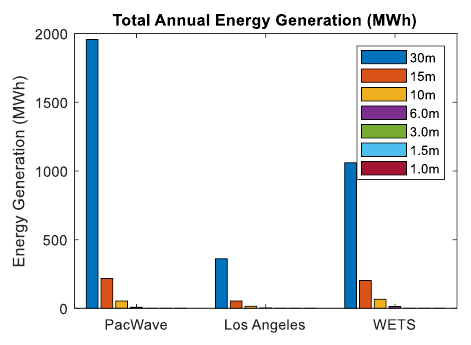
Figure 9: Total energy generation for various WEC size and locations